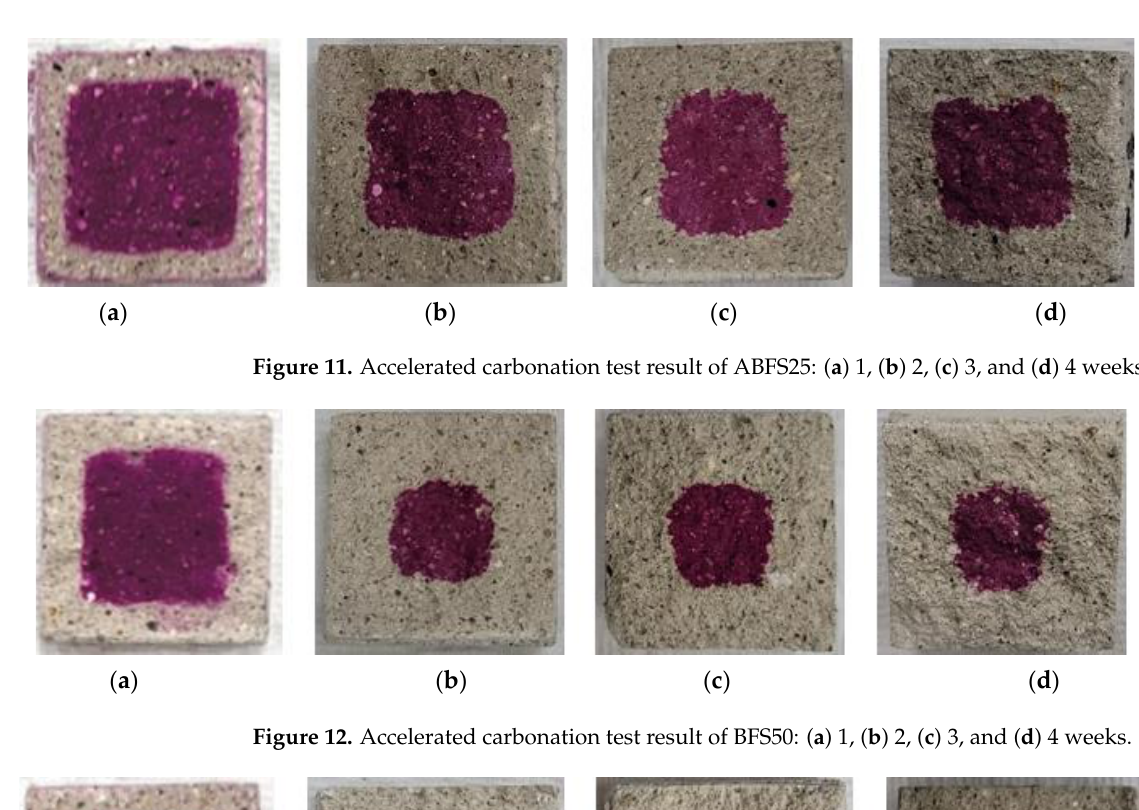
Figure 10. Accelerated carbonation test result of BFS25: ( a ) 1, ( b ) 2, ( c ) 3, and ( d ) 4 weeks.